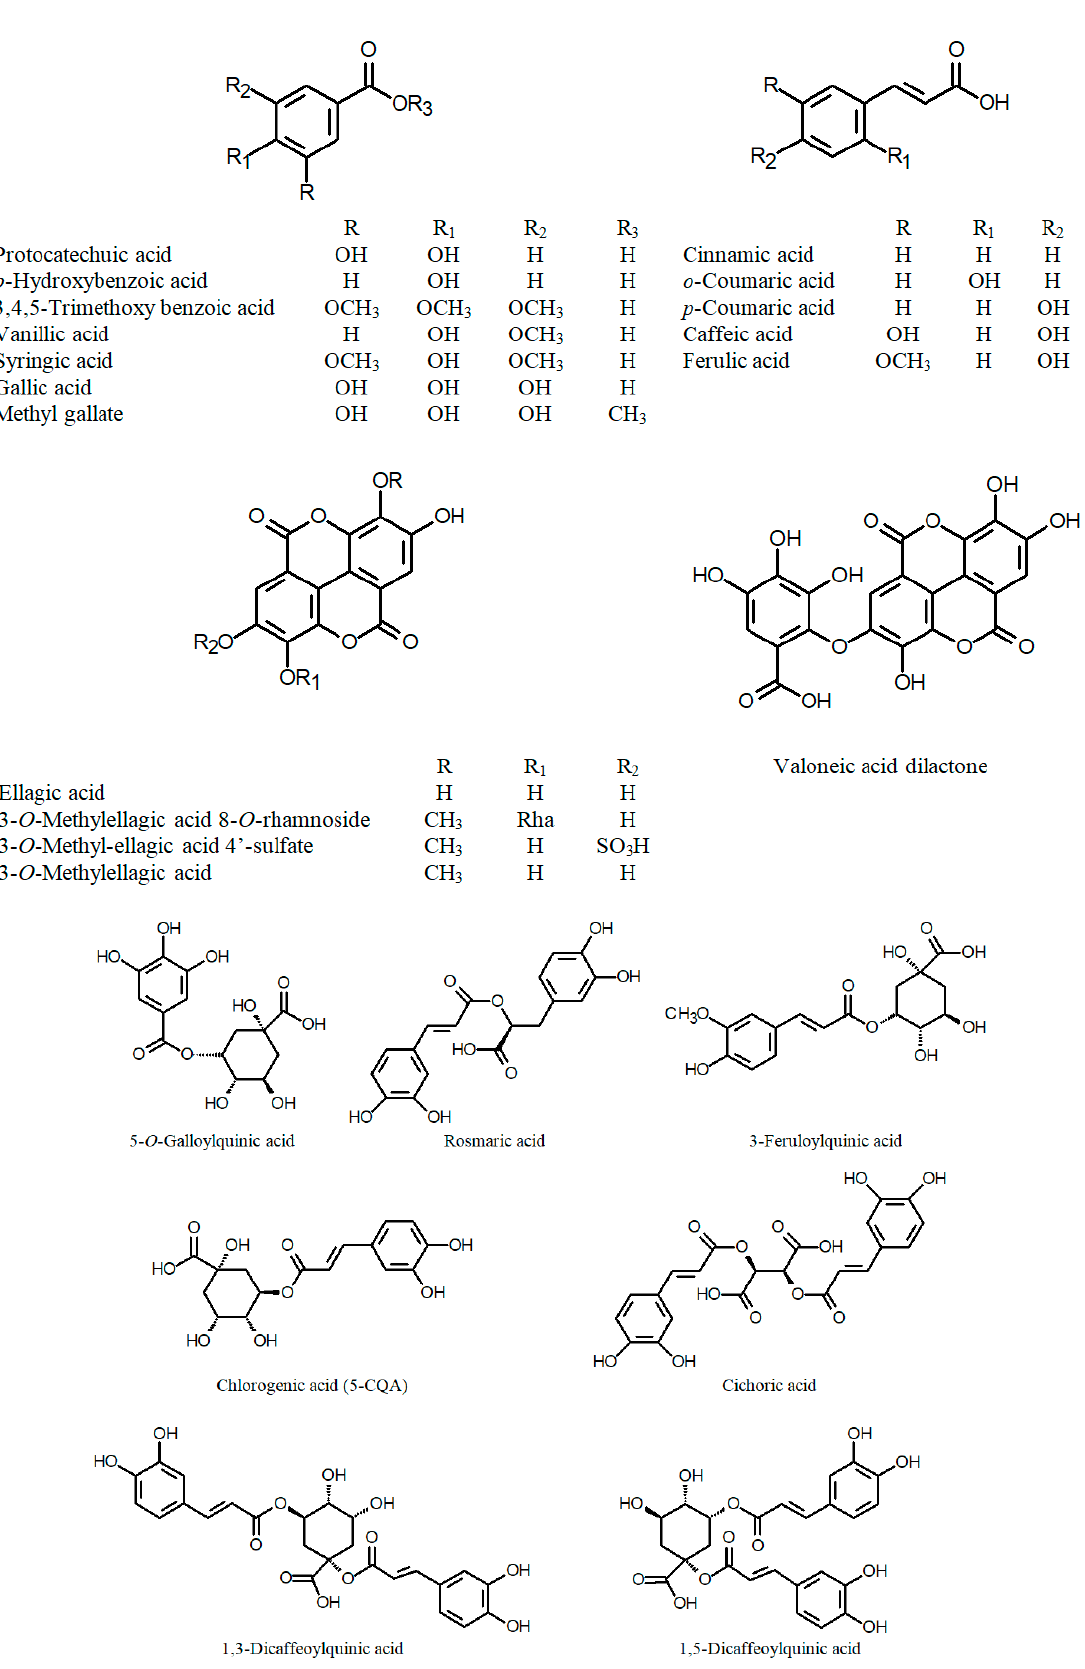
Figure 2. Chemical structures of phenolic acids and their derivatives of the genus Cuphea .